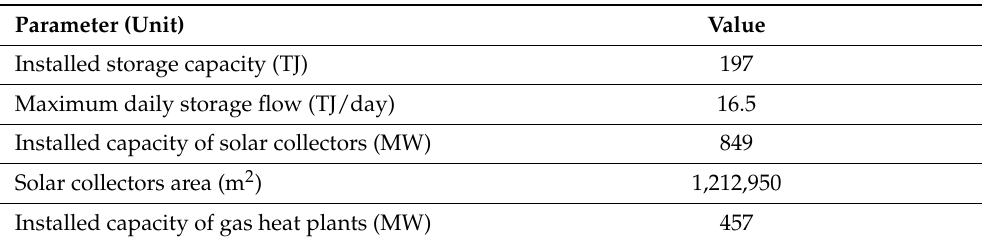
Table 11. The values characterizing the modelled system with the required share of heat from solar collectors = 20%.